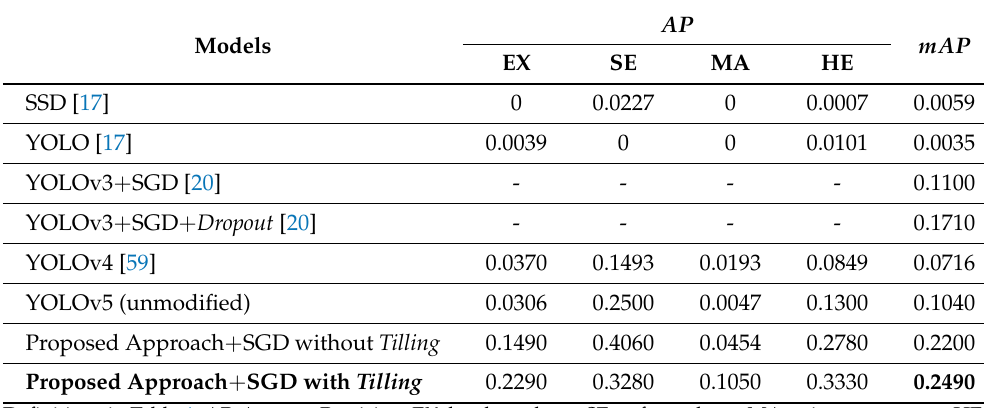
Table 4. Results obtained by the proposed approach with SGD optimizer compared to works related to the metrics AP and mAP for the limit of Intersection over Union of 0.5 in the validation set of the Dataset for Diabetic Retinopathy (DDR).